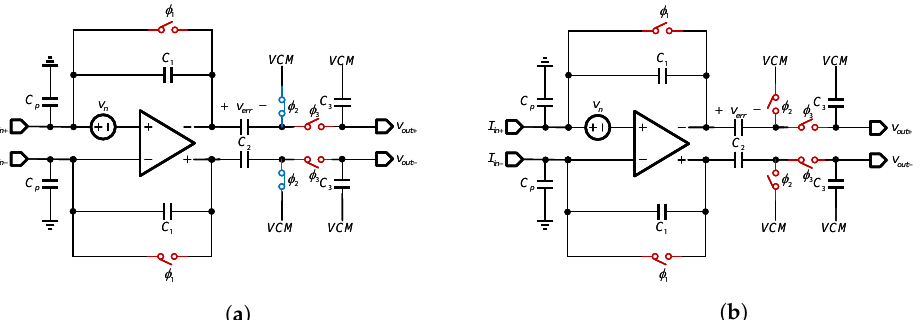
Figure 7. The principle of correlated double sampling (CDS). ( a ) The switch state of the first stage of CDS; ( b ) The switch state of the second stage of